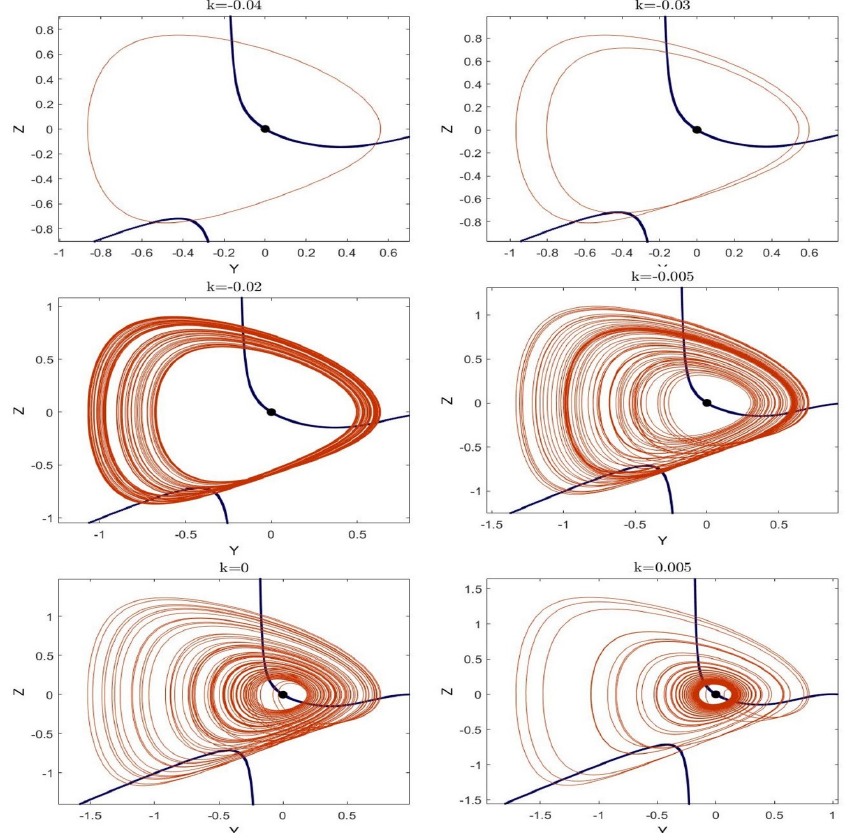
Figure 6. The connecting curves of System (1) for different k values and associated attractors. It is shown that the connecting curves represent the structure of the attractors, and since the structure of attractors did not change majorly, with different k values, the curves remain approximately unchanged.